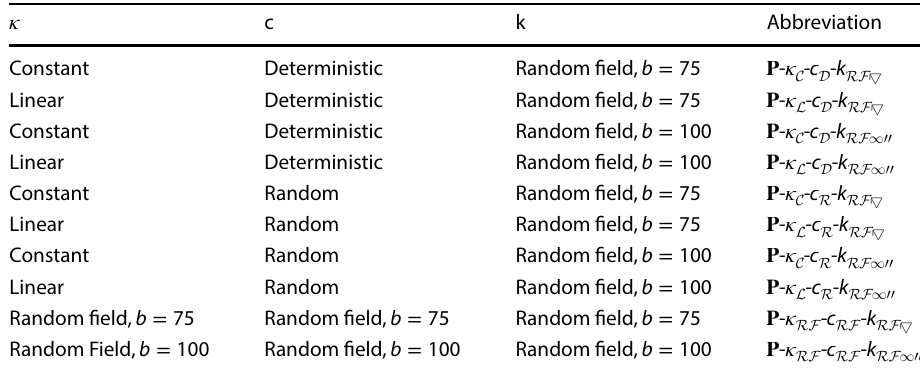
Table 4 Porous analyses performed